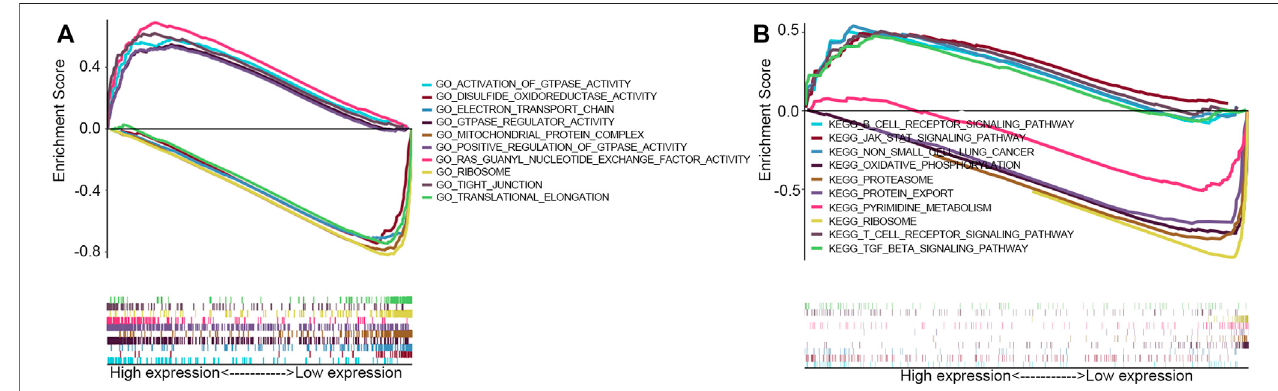
FIGURE 4 | GSEA with GO term and KEGG pathway. (A) GO terms analysis revealed the most fi ve positively correlated pathways and fi ve most negatively correlated pathways. (B) KEGG pathways analysis showed the most fi ve positively correlated pathways and fi ve most negatively correlated pathways.